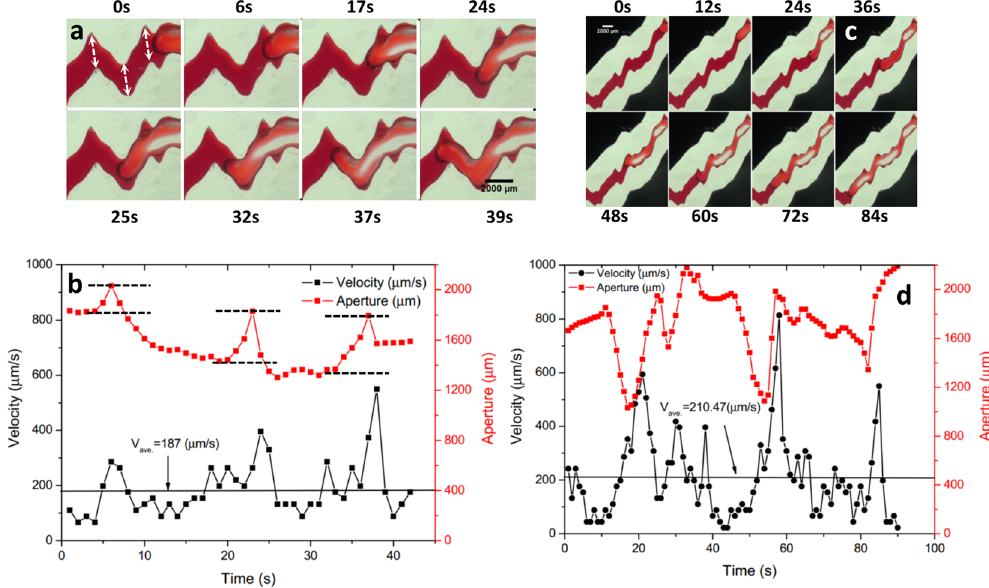
Figure 3. Time-lapse images showing interfacial dynamics in typical aperture geometries: ( a ) Out-of-phase #1 and ( c ) Out-of-phase #2. Temporal changes in interfacial velocity and corresponding aperture width for Out- phase #1 ( b ) and Out-phase #2 ( d ). The white arrows in ( a ) mark the three inflection zones in the “V”-shaped channel and the black dotted lines in ( b ) bound the aperture